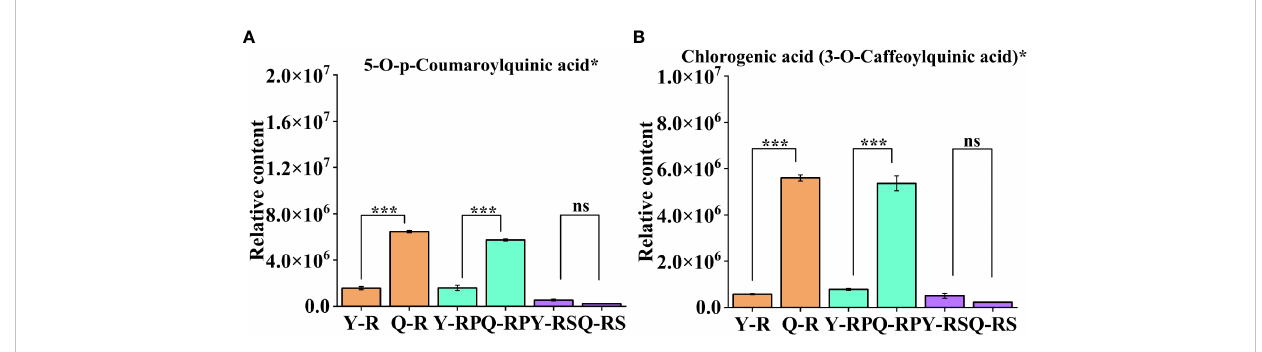
FIGURE 9 Variation of two selected bioactive phenolic acid in two plateaus. 5-O-p-Coumaroylquinic acid* (A) ; Chlorogenic acid (3-O-Caffeoylquinic acid)* (B) . Bars indicate the s.d. of three replicates. “ ns ” means not signi fi cant, *** p < 0.005.